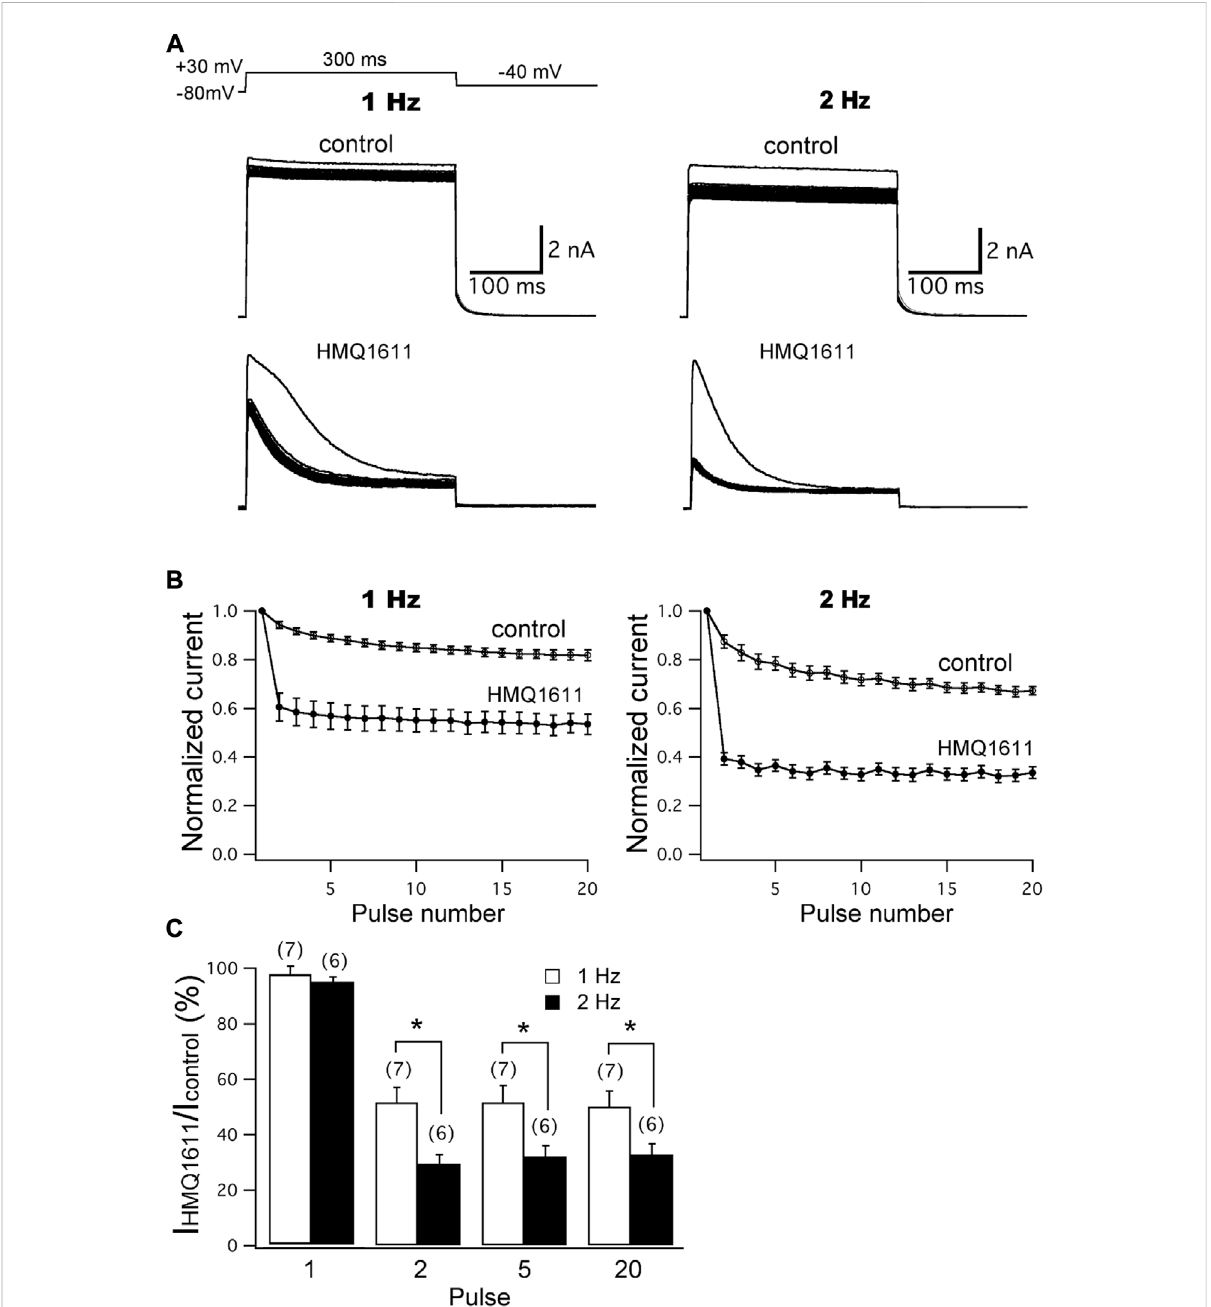
FIGURE 3 Frequency-dependent block of hKv1.5 current by HMQ1611. (A) Original current traces of hKv1.5 in the absence and presence of 5 μ M HMQ1611at two different frequencies (1 and 2 Hz) were obtained using a train of 20 depolarizing steps of 200 ms duration from -80 mV to +50 mV followed by a 200 ms repolarization step to -40 mV. (B) Peak amplitudes of outward current at every pulse were normalized with reference to the peak amplitude of current obtained at the fi rst pulse and then plotted against the pulse numbers. (C) Normalized current amplitudes for pulse number 1, 2, 5, and 20 before and after the application of 5 μ M HMQ1611, obtained at the two frequencies. Experiment numbers are shown in parenthesis. Data are demonstrated as mean ± SEM. * p < 0.05 vs . normalized current amplitude at 1